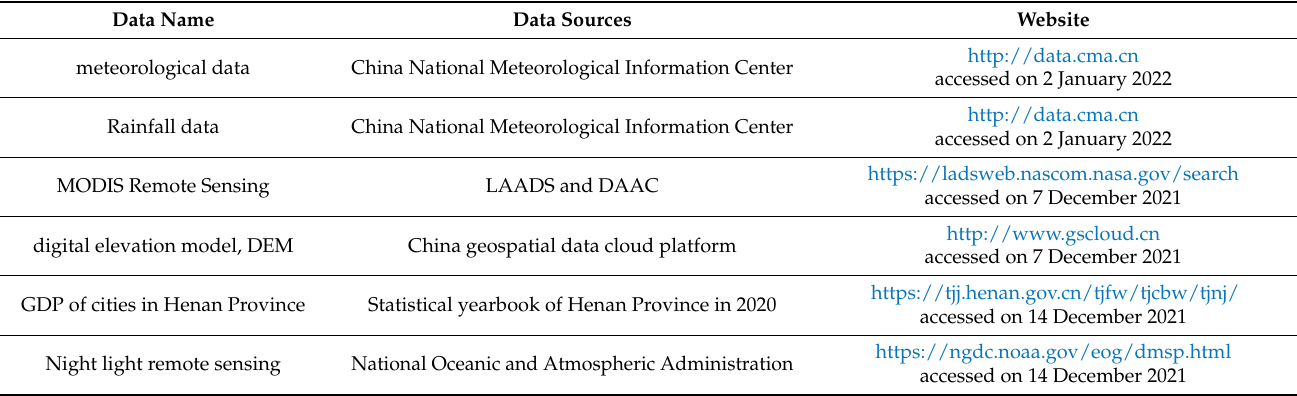
Table 1. Statistical table of data name and